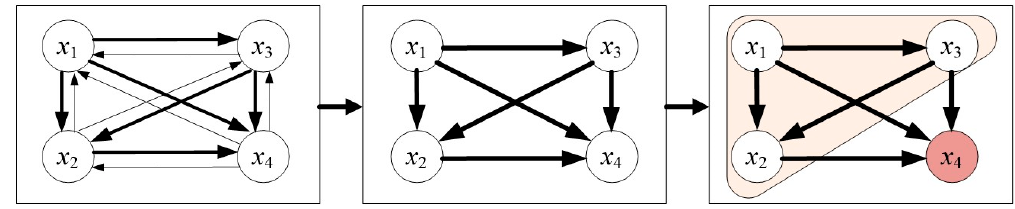
Figure 2. Development of the INRM (Influential Network Relation Map) and formulation of improvement strategies.